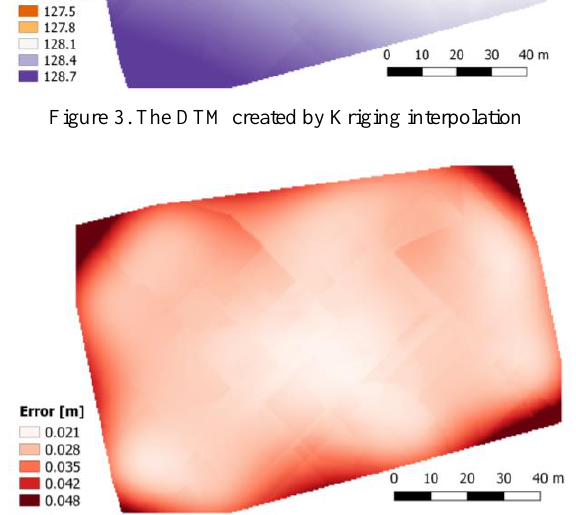
Figure 4. Kriging error prediction map